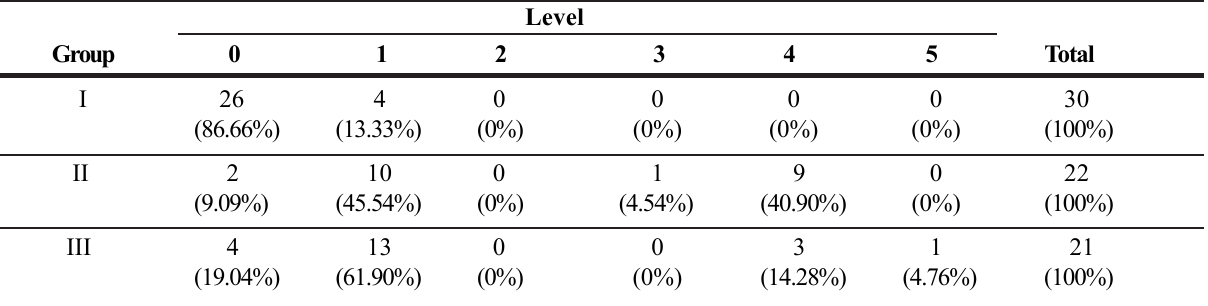
TABLE 2 - Animals distribution in relation to the adhesions level according to the group, excluding the deaths before euthanasia Level